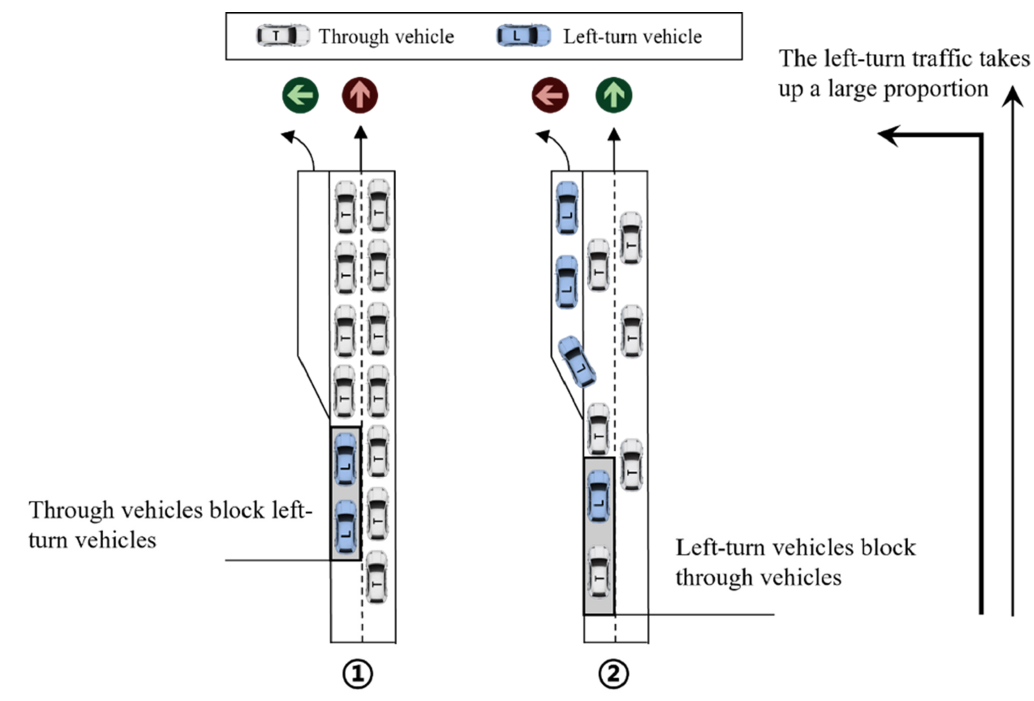
Figure 4. Considering only through vehicles causes queuing congestion.